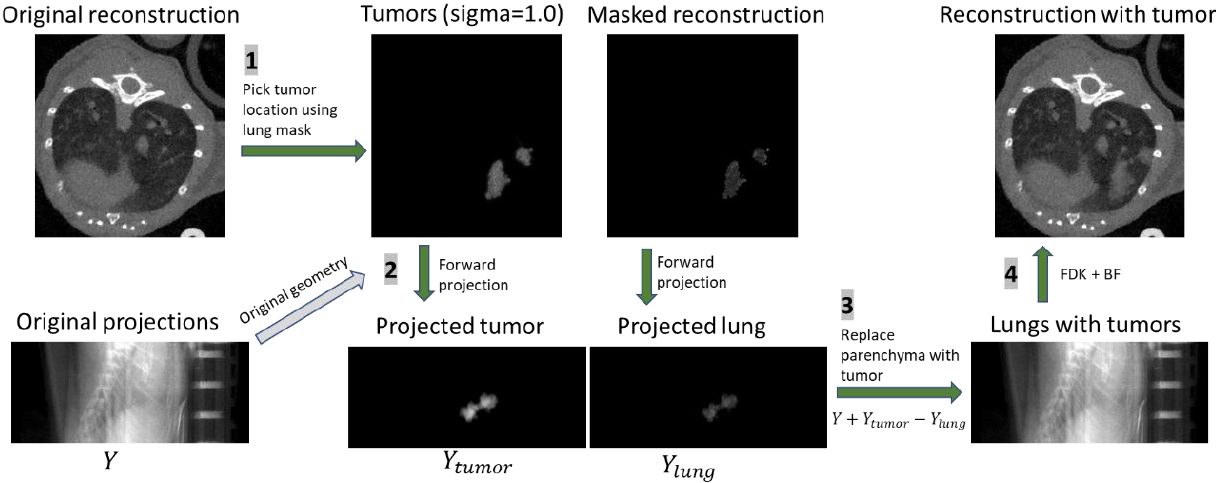
Figure 2. Diagram showing the generation of simulated lung tumors. (1) A scan of a healthy mouse is used as the base. (2) Tumors are added to empty volumes which are projected into the same space as the original projections. (3) The tumor is added and the lung subtracted from the original projections. (4) The reconstruction with lung tumors is performed via FDK followed by bilateral filtration (BF).